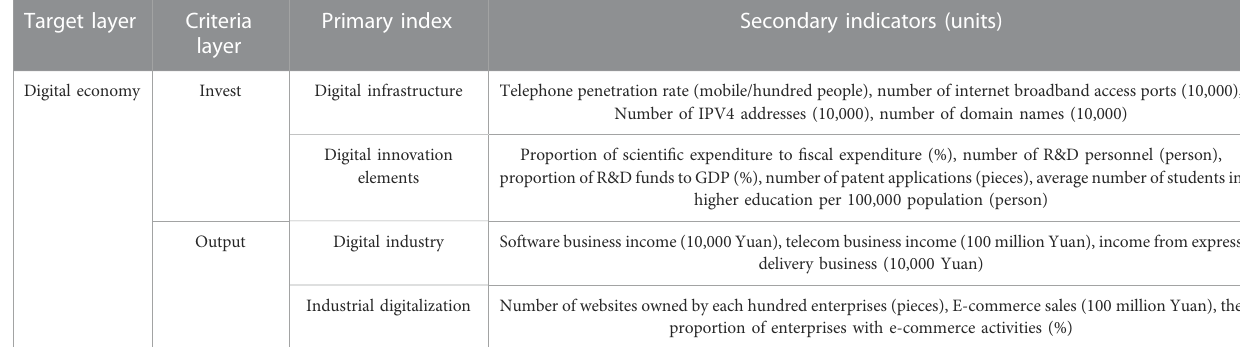
Primary index layer